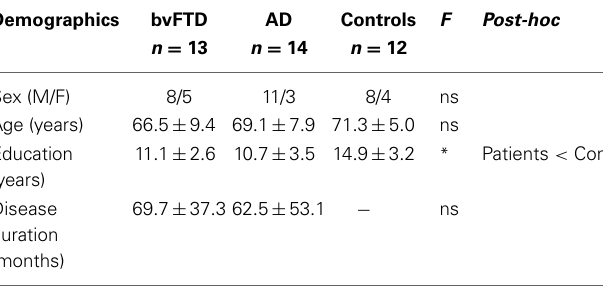
Table 2 | Demographic characteristics of the study